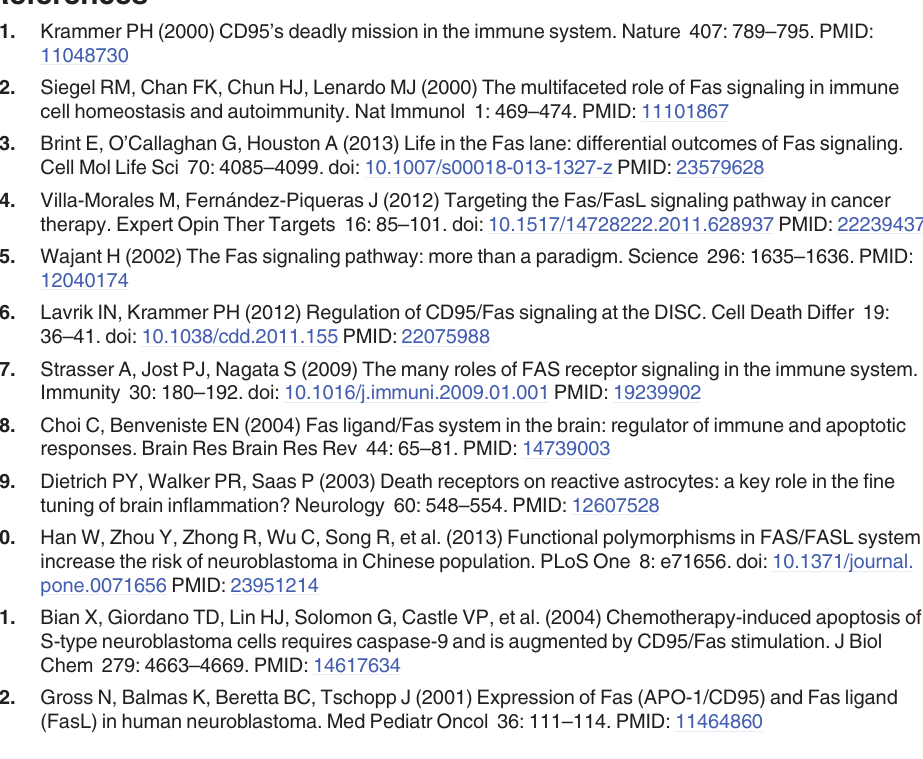
S1 Fig. Fas does not affect caspase-4 expression in appearance. SH-EP1 cells transfected with control vector (Ctl) or DN-I κ B α expression vector (DN-I κ B α ) were treated with anti-Fas anti- body (100 ng/ml) for a time course as indicated. Cells were lysed and Western blotting analysis was carried out using corresponding antibodies. Data are representative of three independent experiments. S2 Fig. Activation of NF- κ B by Fas does not induce Fas expression. SH-EP1 cells transfected with control vector (Ctl) or DN-I κ B α expression vector (DN-I κ B α ) were treated with anti-Fas antibody (100 ng/ml) for 1d. The relative mRNA levels of caspase-4 in DN-I κ B α cells were de- termined by qPCR. Data are representative of three independent experiments and shown as av- erage ±